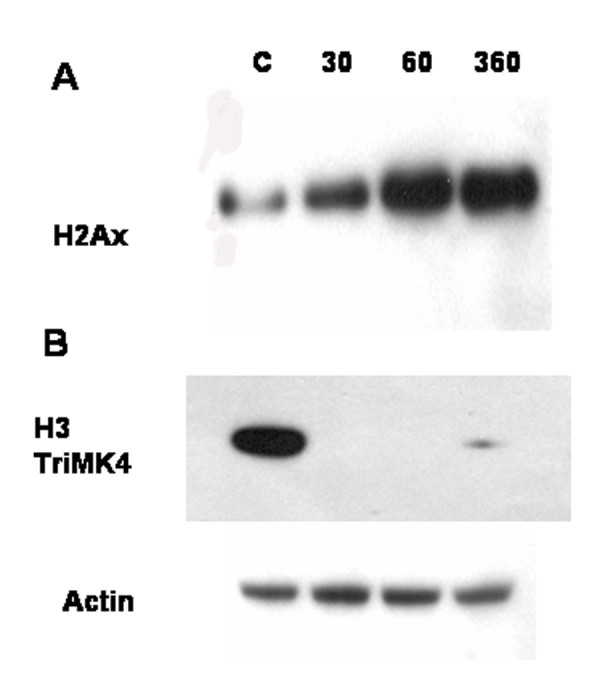
Histone phosphorylation and methylation. Western blots probed with A. antiphospho-H2A (Ser-139) and B. trimethyl-K4 H3 histone. Phosphorylation of H2A increased while methylation of histone H3 (at lysine-4) decreased after optic nerve injury. The demethylation of H3 persisted for several hours and started to recover at 6 hr post injury. Actin served as a loading control in these experiments.